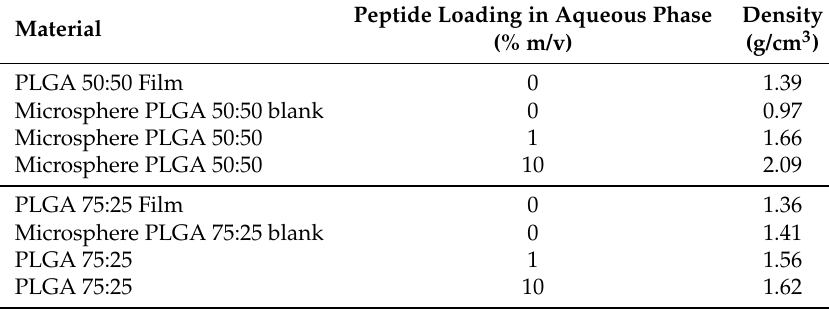
Table 3. Helium pycnometry data for lyophilized microsphere samples and PLGA 50:50 and 75:25 copolymer films.